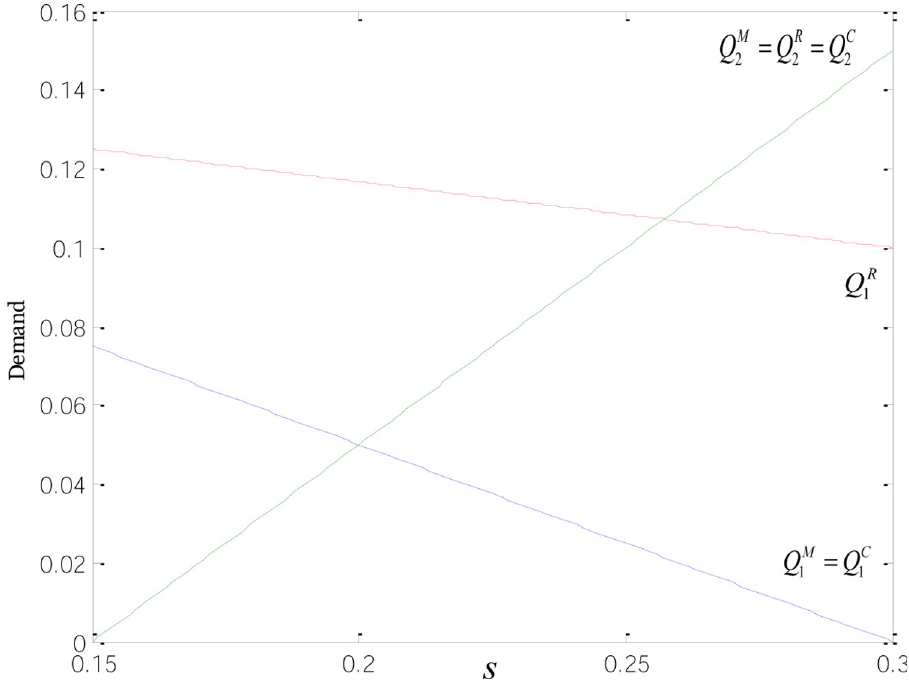
Fig 5. Relationships between product demand and low-carbon